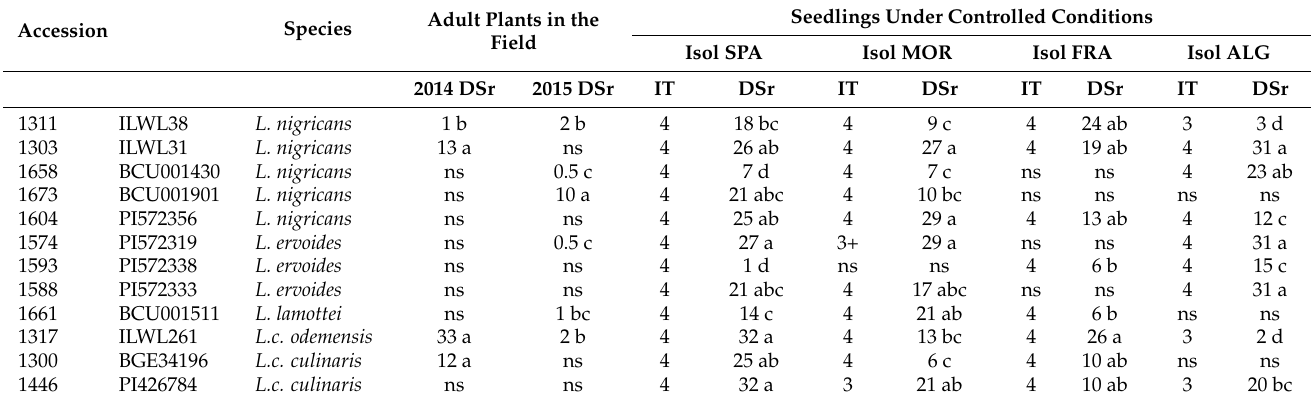
Screenings allowed identification of Adult Plant Resistance (APR) not based on hyper-